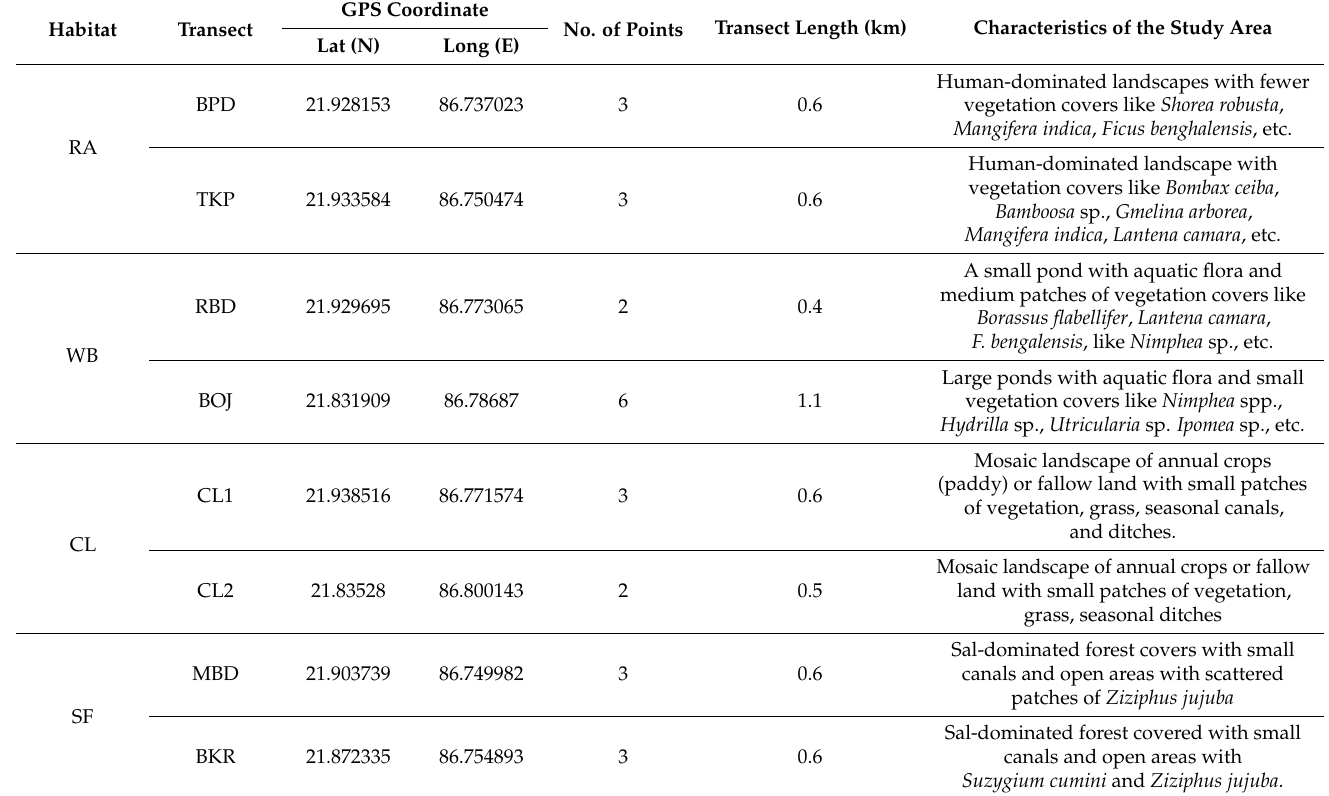
Table 1. Description of different habitat types in the study